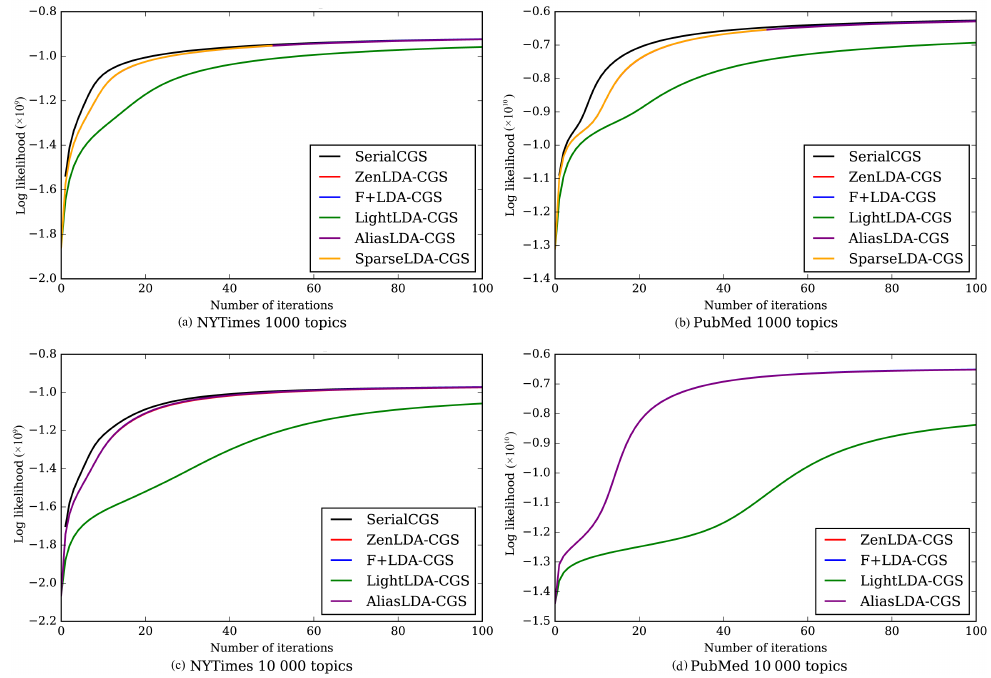
Fig. 4 Log-likelihood comparison among different CGS algorithms. Note that the curves of SparseLDA, F+LDA, AliasLDA, and ZenLDA-CGS are almost the same and some of them get